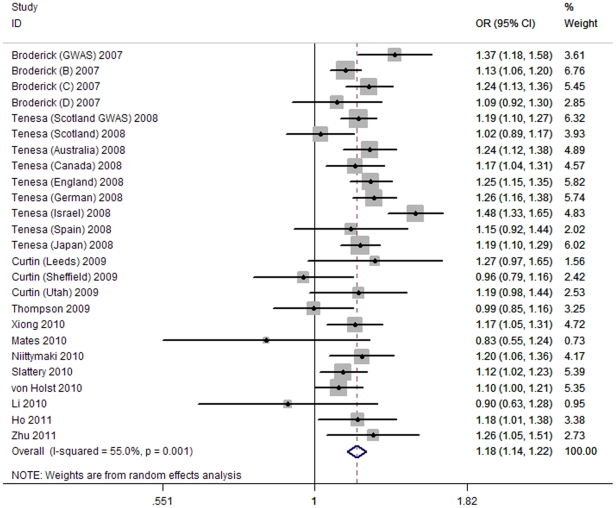
Forest plot of association of rs4939827 with CRC under allelic model.